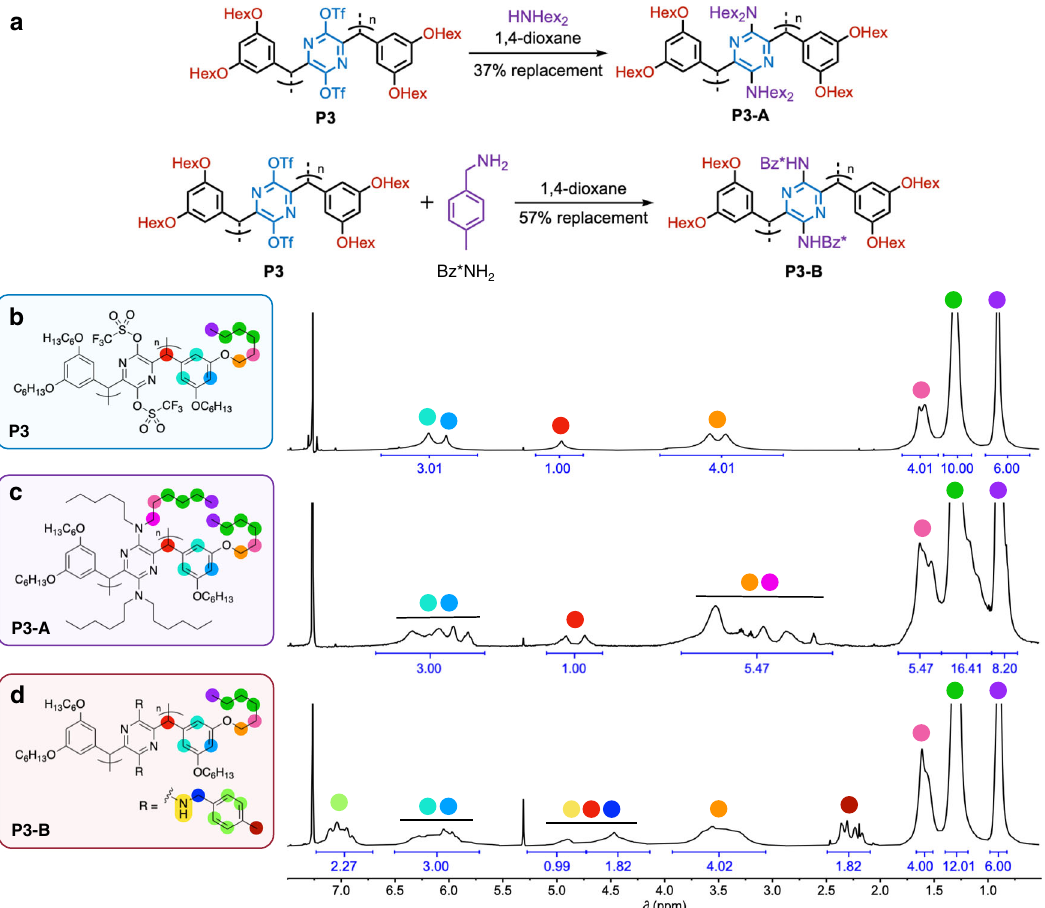
Fig. 4 Postpolymerization functionalization of polymer P3 with amines. a The synthesis of two amine-functionalized polymers from reacting polymer P3 with primary and secondary amine nucleophiles. b – d 1 H NMR spectra of ( b ) polymer P3 and its postpolymerization functionalization products, ( c ) P3-A and ( d ) P3-B , showing 37%, and 57% tri fl ate replacement, respectively. All proton resonances are annotated by colored